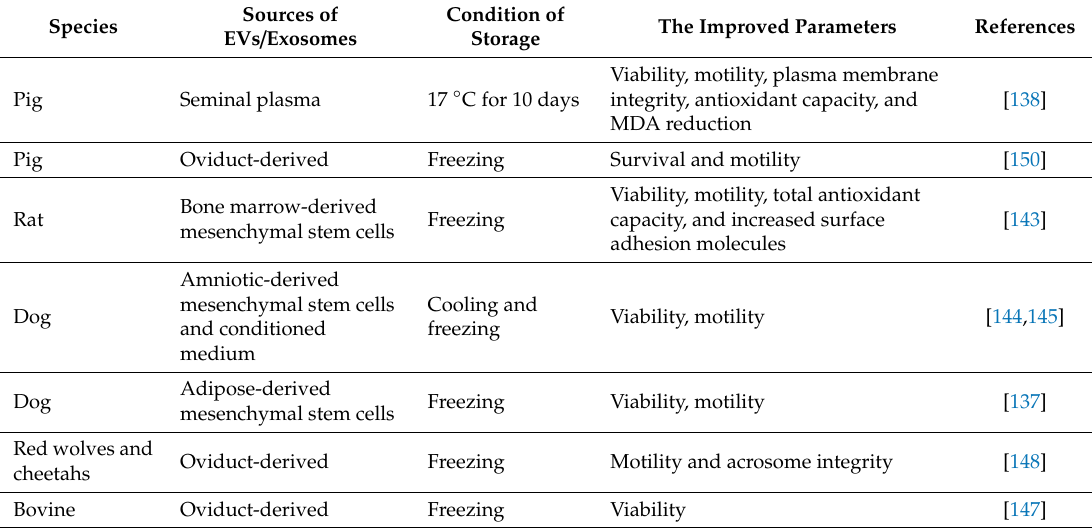
Table 2. Main literature reporting the beneficial e ff ects obtained following the supplementation of exosomes for semen